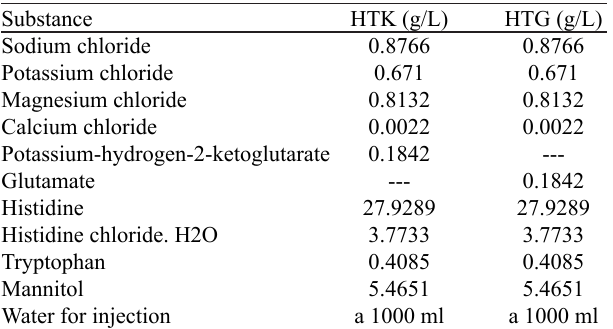
Table 1. Composition of solutions used Substance